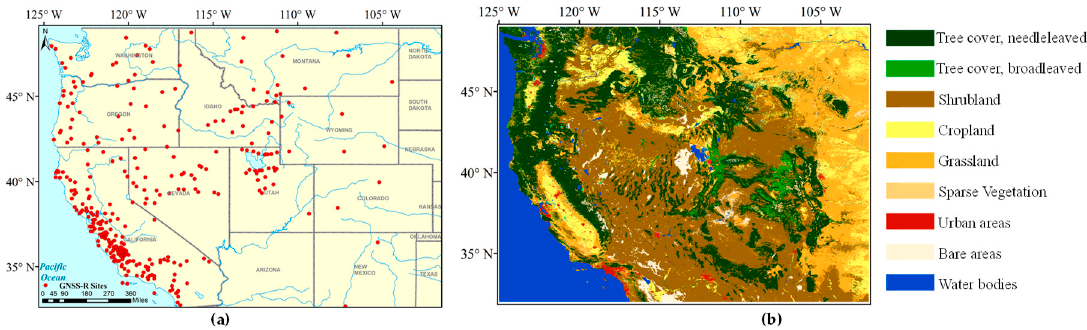
Figure 1. Study area in the western part of the CONUS. ( a ) Study area and PBO H2O sites (https: // gnss-h2o.jpl.nasa.gov / index.php). ( b ) Land cover map in 2015 (http: // maps.elie.ucl.ac.be / CCI / viewer /